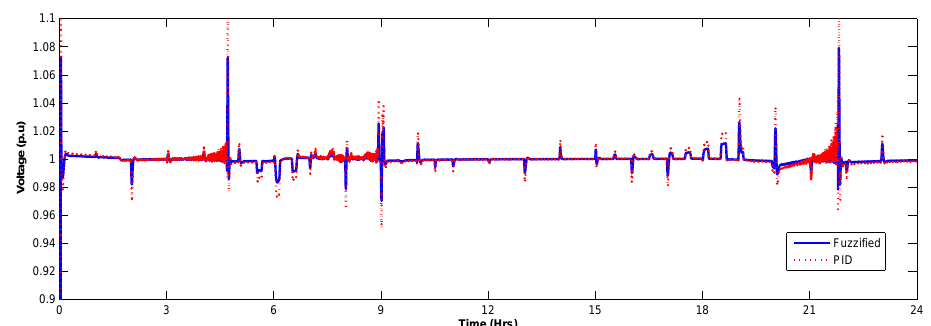
Figure 24. DC bus voltage deviation: EMS based on fuzzy logic controller versus EMS based on PID